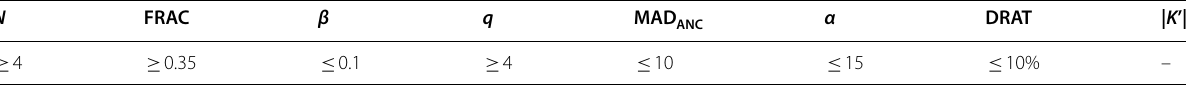
N is the number of data points on the Arai plot. FRAC is a measure of the amount of NRM used. The parameter β is a measure of the Arai plot data scatter, q is the quality factor, MAD ANC and α are measures of how well a specimen’s direction trends to the origin. DRAT checks for alteration by comparing the error to the length of the best-fit line, and | K ’| measures the curvature of the selected portion of the Arai plot. Parameters were calculated according to the standard palaeointensity definitions (Paterson et al. 2014) * | K ’| was not used as an explicit selection criterion but will rather be used as a measure of the technique’s efficacy. Additional file 1 contains the data suggested for